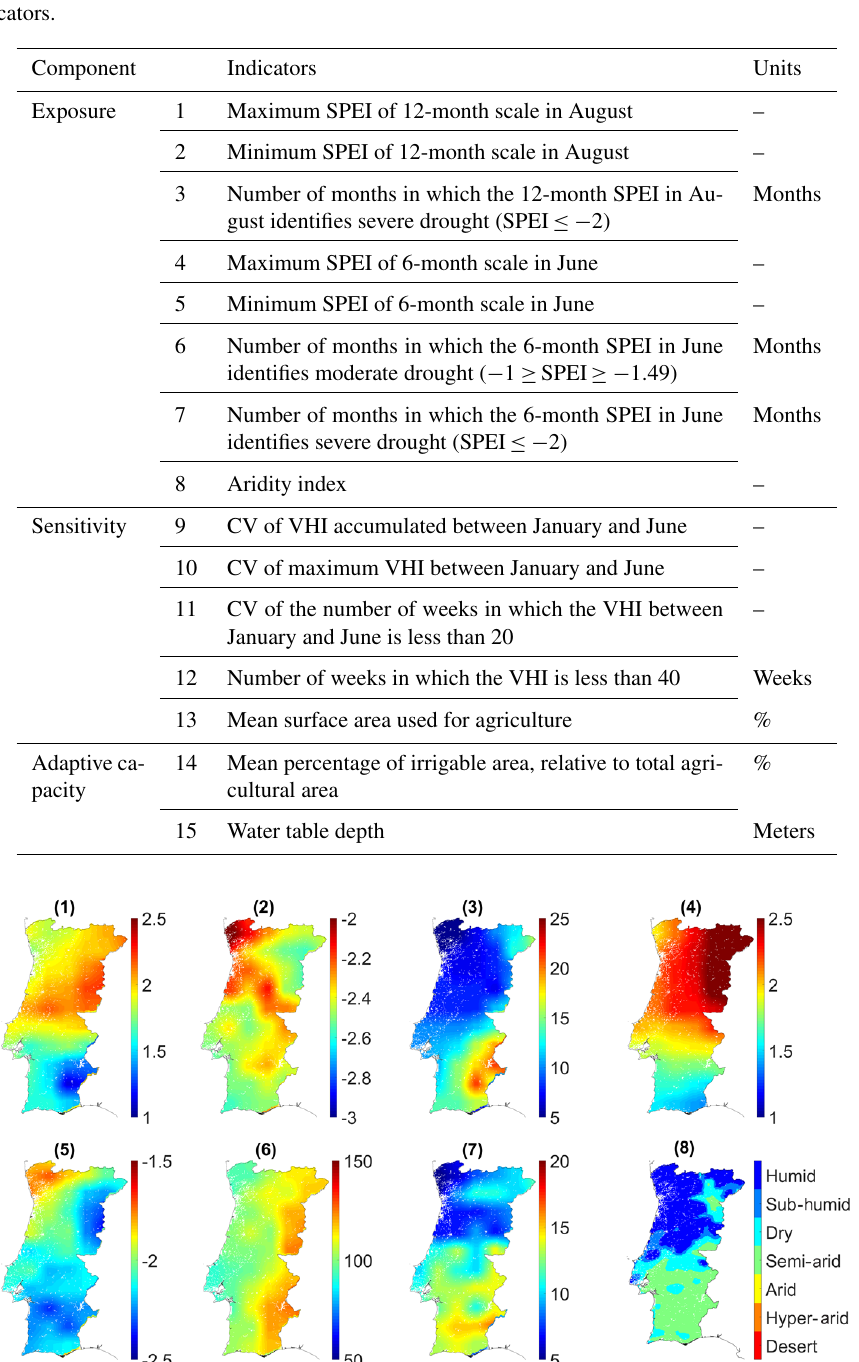
Figure 1. Spatial distribution of different indicators used to assess the exposure component. The title numbers correspond to the number of the indicators in Table